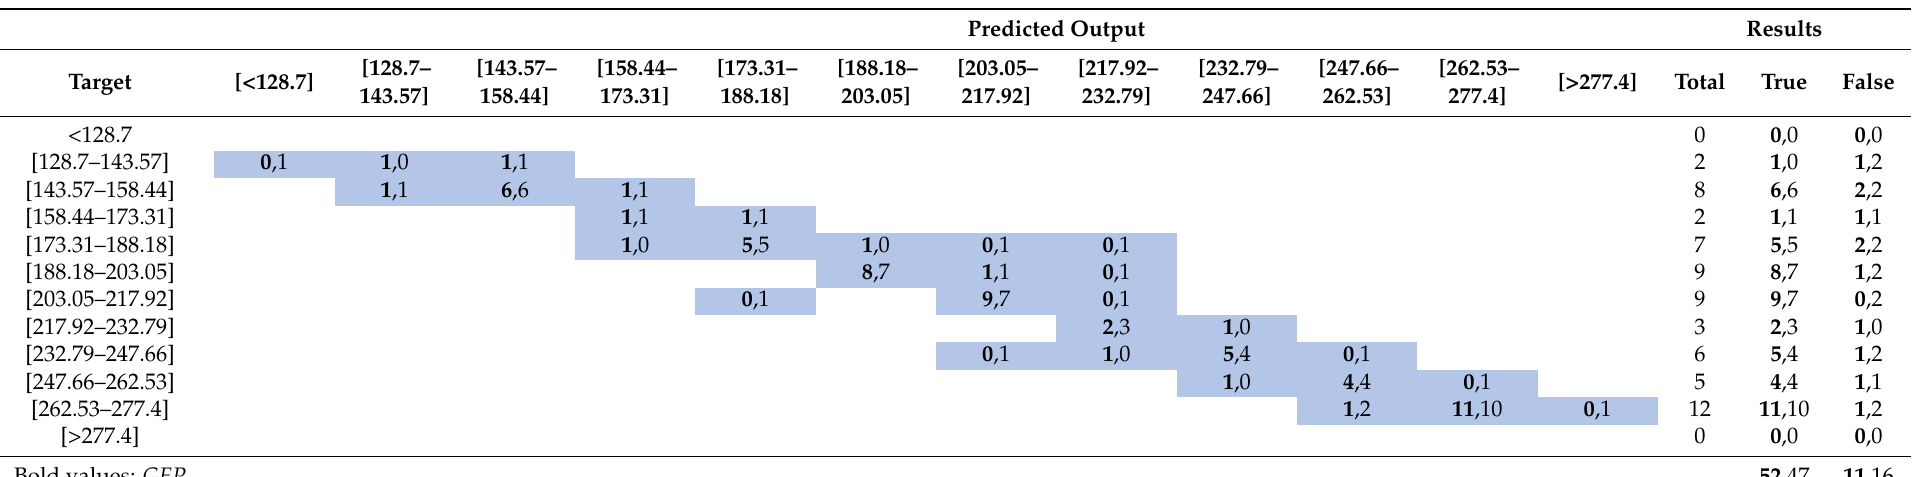
Table 2. Predictability and observed improvement of GEP and OK (The bolded numbers are referred to